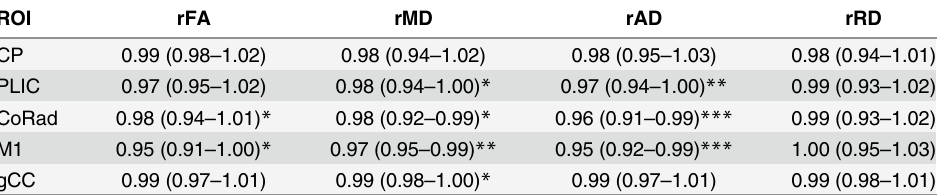
Ratios given as Median (IQR). Signi fi cant differences between contra and ipsilesional sides given as * p (cid:3)